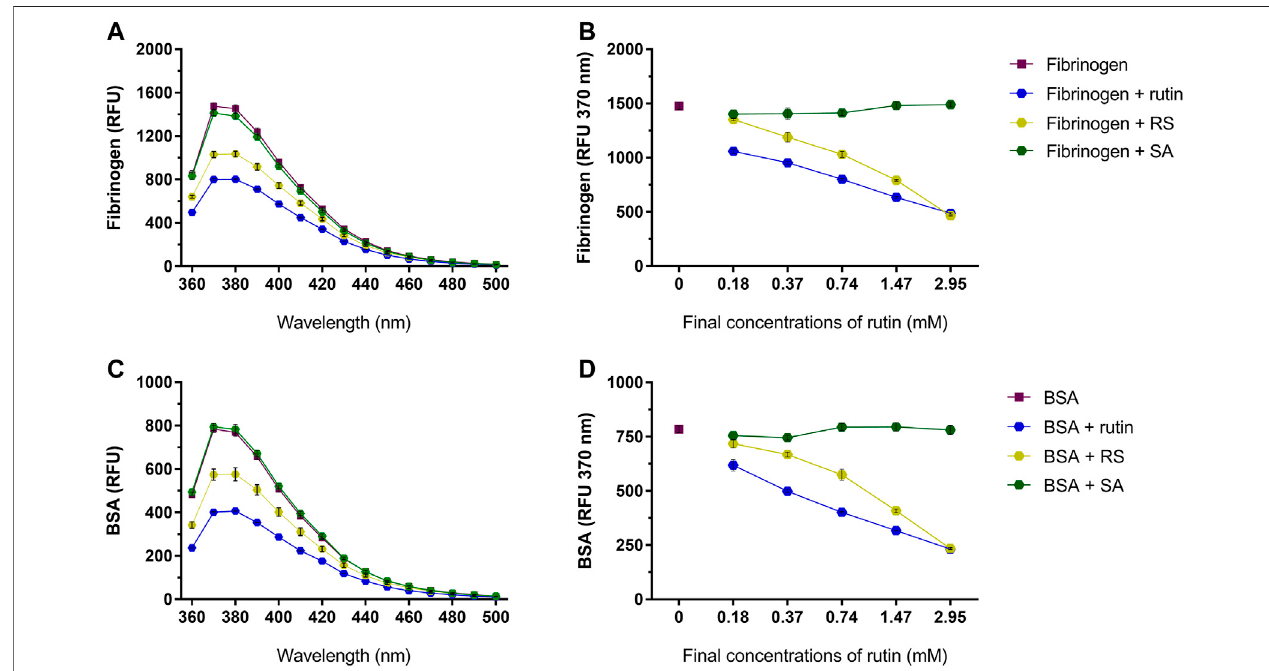
FIGURE 6 | Activity of rutin, RS and SA at different concentrations on the fl uorescence spectra of (A,B) bovine fi brinogen and (C,D) BSA. Data are expressed as RFU, and assays were carried out in triplicate.